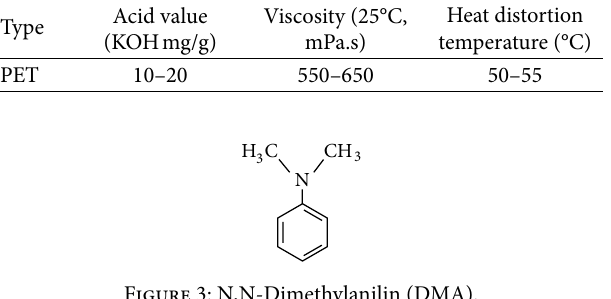
Figure 3: N,N-Dimethylanilin (DMA).